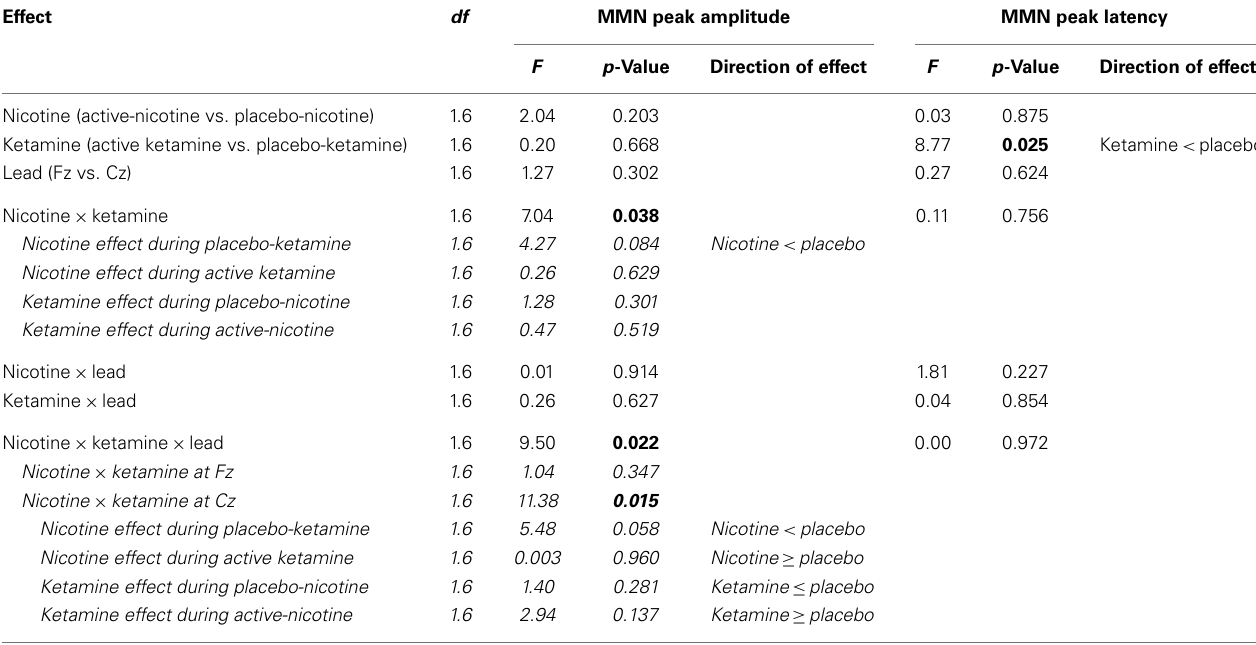
Table 7 |Analysis of variance (ANOVA) of MMN peak amplitudes and latencies